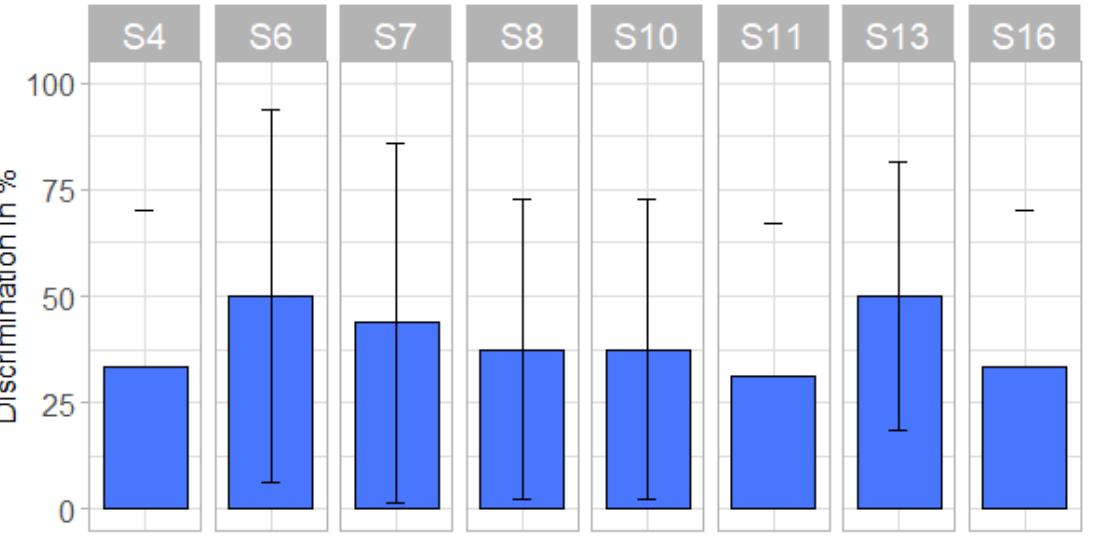
Figure 2. Discrimination of contrasts by each subject in the low IQ group.